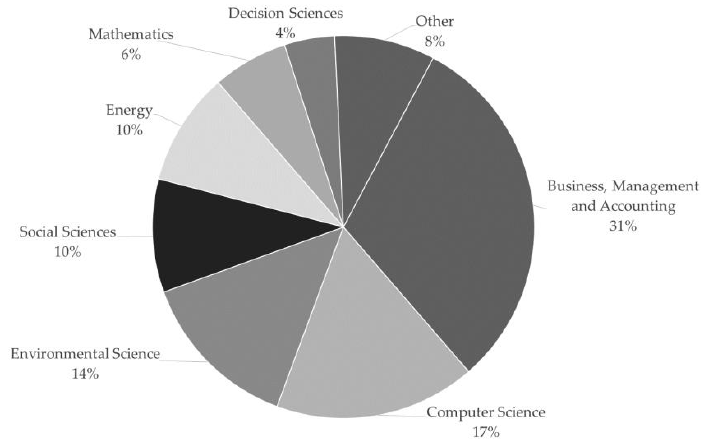
Figure 3. Articles per additional subject area.